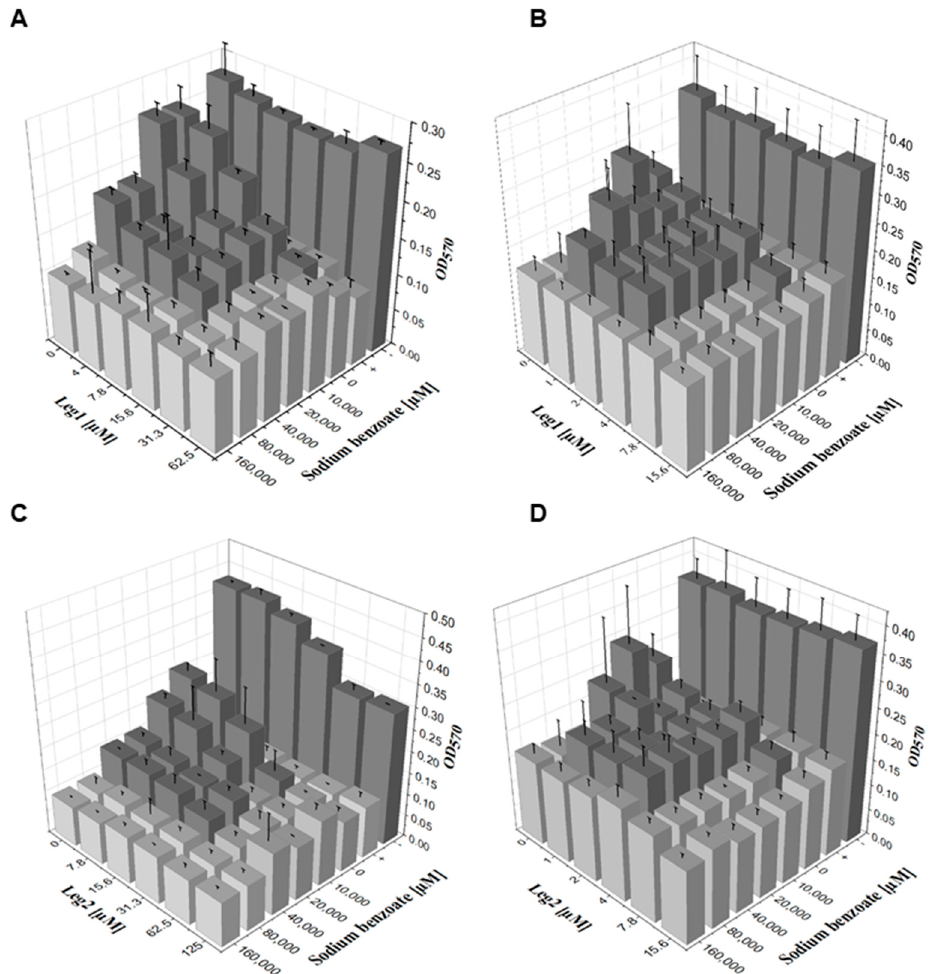
Figure 2. Results of a checkerboard assay using Leg1 or Leg2 combined with sodium benzoate against ( A , C ) E. coli and ( B , D ) B. subtilis to determine the fractional inhibitory concentration (FIC) indices. Water was used as negative control ( − ) and ampicillin (+) as positive control. The optical density is displayed as mean ± SD of triplicates measured at 570 nm. Bacterial growth is indicated in dark grey.